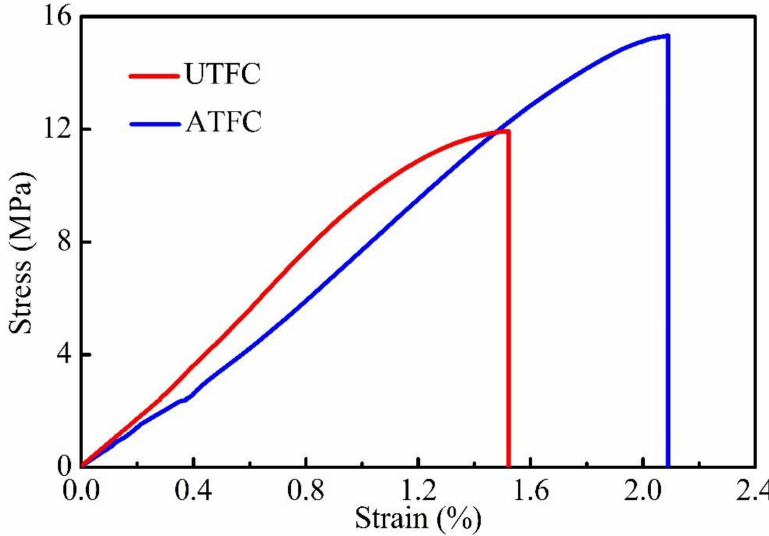
Figure 1. Typical stress-strain curves of some composite specimens from tensile